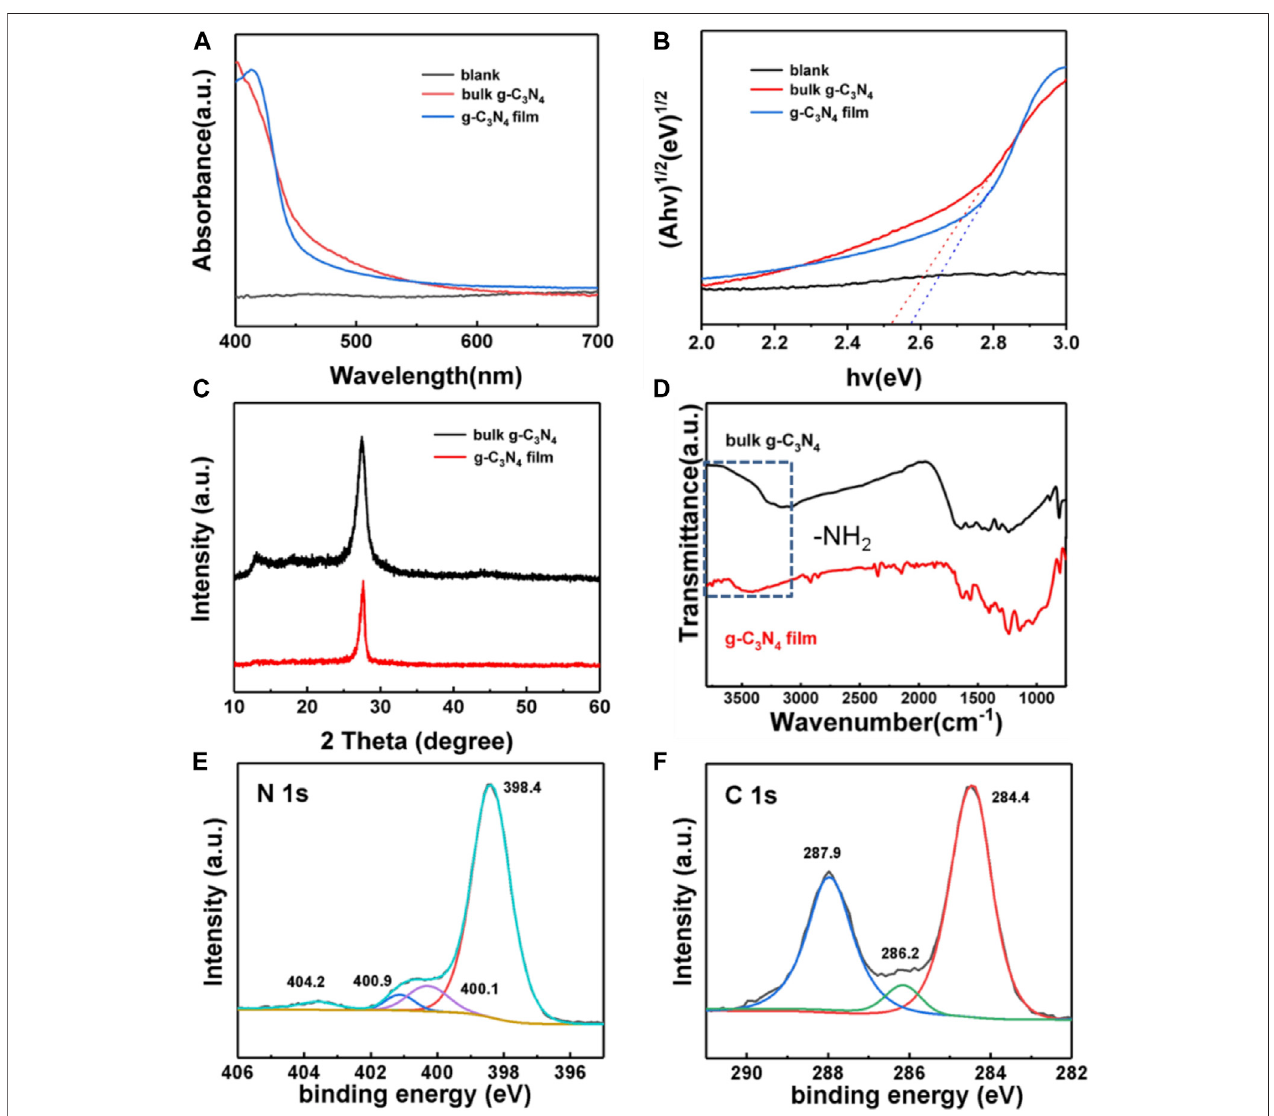
FIGURE 2 | (A) UV – Vis absorption spectra of blank glass (black line), bulk g-C 3 N 4 (red line) and g-C 3 N 4 fi lm (blue line), respectively. (B) Tauc plots of blank glass (black line), bulk g-C 3 N 4 (red line) and g-C 3 N 4 fi lm (blue line), respectively. (C) XRD diffraction patterns of bulk g-C 3 N 4 (black line) and g-C 3 N 4 fi lm (red line). (D) Infrared spectra of bulk g-C 3 N 4 (black line) and g-C 3 N 4 fi lm (red line). (E) Typical N 1s and (F) C 1s XPS spectra of g-C 3 N 4 fi